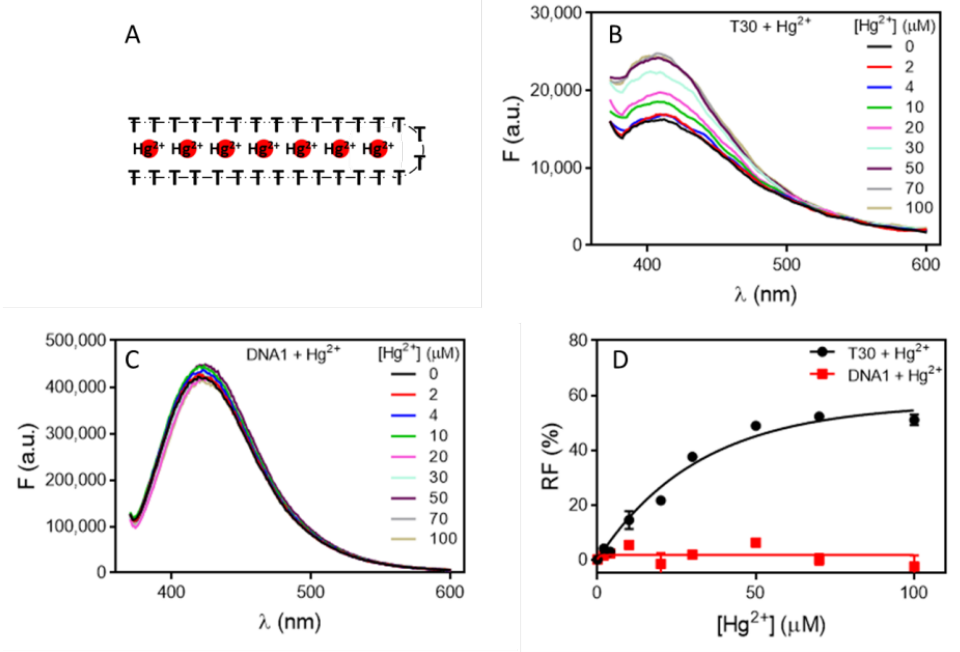
Figure 3. ( A ) A scheme showing Hg 2+ binding to T30 DNA and each DNA was estimated to bind around 13 Hg 2+ ions. The fluorescence spectra of ( B ) T30 and ( C ) DNA1 upon titration of Hg 2+ with 320 nm excitation. ( D ) The fitted binding curve of the two DNAs. 320 nm excitation. ( D ) The fitted binding curve of the two